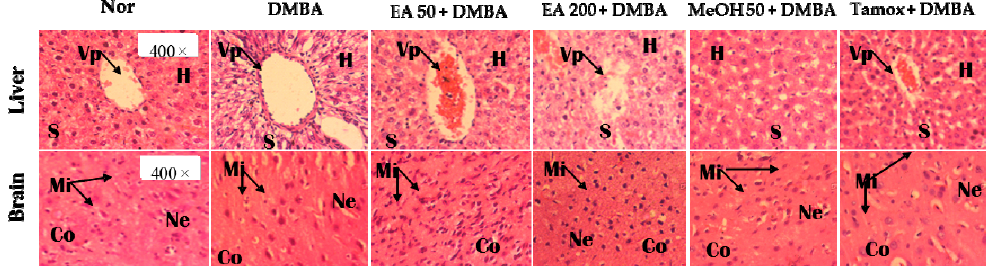
Figure 12. Effects of F. umbellata extracts on microphotographs H&E (400 × ) of liver ( top ); and brain ( bottom ) after 20 weeks of treatment. Control, Normal control treated with 2% ethanol; DMBA, DMBA control treated with 2% ethanol; EA + DMBA, Animals treated with the F. umbellata aqueous extract at the doses of 50 and 200 mg/kg. MeOH + DMBA, Animals treated with the F. umbellata methanol extract at the dose of 50 mg/kg. TAM + DMBA, Animals treated with tamoxifen (3.3 mg/kg); All groups excepting the normal group (Nor) received an intragastric dose of DMBA at the dose of 50 mg/kg followed by a 10-day subcutaneous administration of 17 β -estradiol (5 mg/kg). Data are represented as mean ± SEM ( n = 10). Vp, portal vein; H, Hepatocyte; S, sinusoids; Mi, microglia; Ne, Neuron; Co, Cortex.